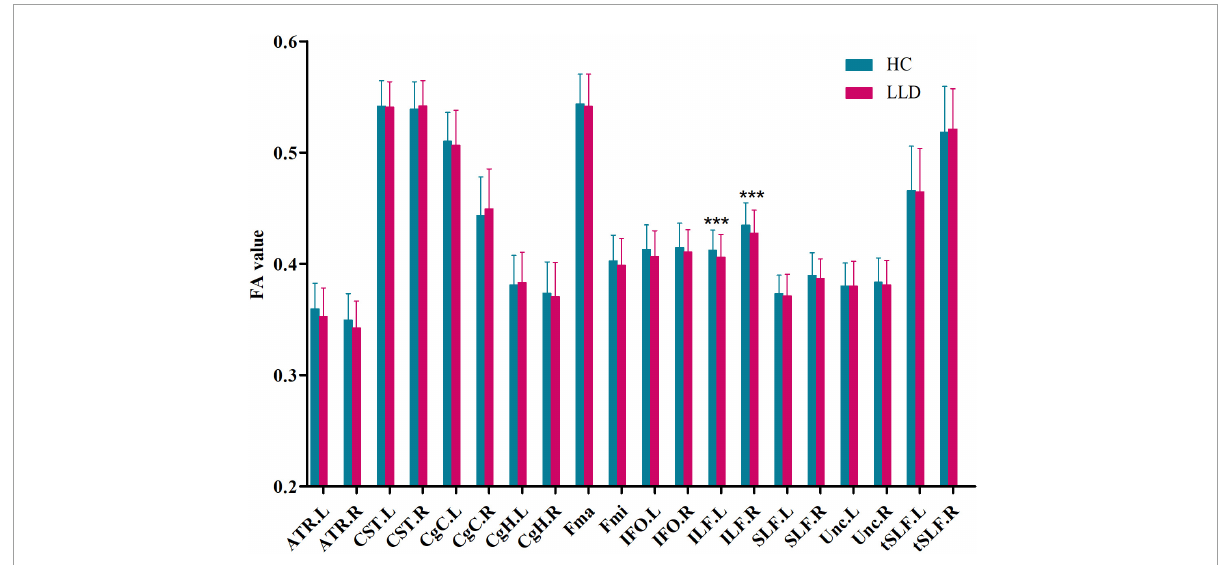
FIGURE1 Group comparisons of the mean FA value of each tract in HCs and LLD patients. Each bar represents the mean ± SD. Analysis of covariance (ANCOVA) using age, sex, and education as covariates. *** indicates q < 0.05 after FDR correction. HC, healthy control; LLD, late-life depression; FA, fractional anisotropy; L, left, R, right; ATR, anterior thalamic radiation; CST, corticospinal tract; CgC, cingulum of the cingulate cortex; CgH, cingulum of the hippocampus; Fma, forceps major; Fmi, forceps minor; IFO, inferior fronto-occipital fasciculus; ILF, inferior longitudinal fasciculus; SLF, superior longitudinal fasciculus; Unc, uncinate fasciculus; tSLF, superior longitudinal fasciculus (temporal